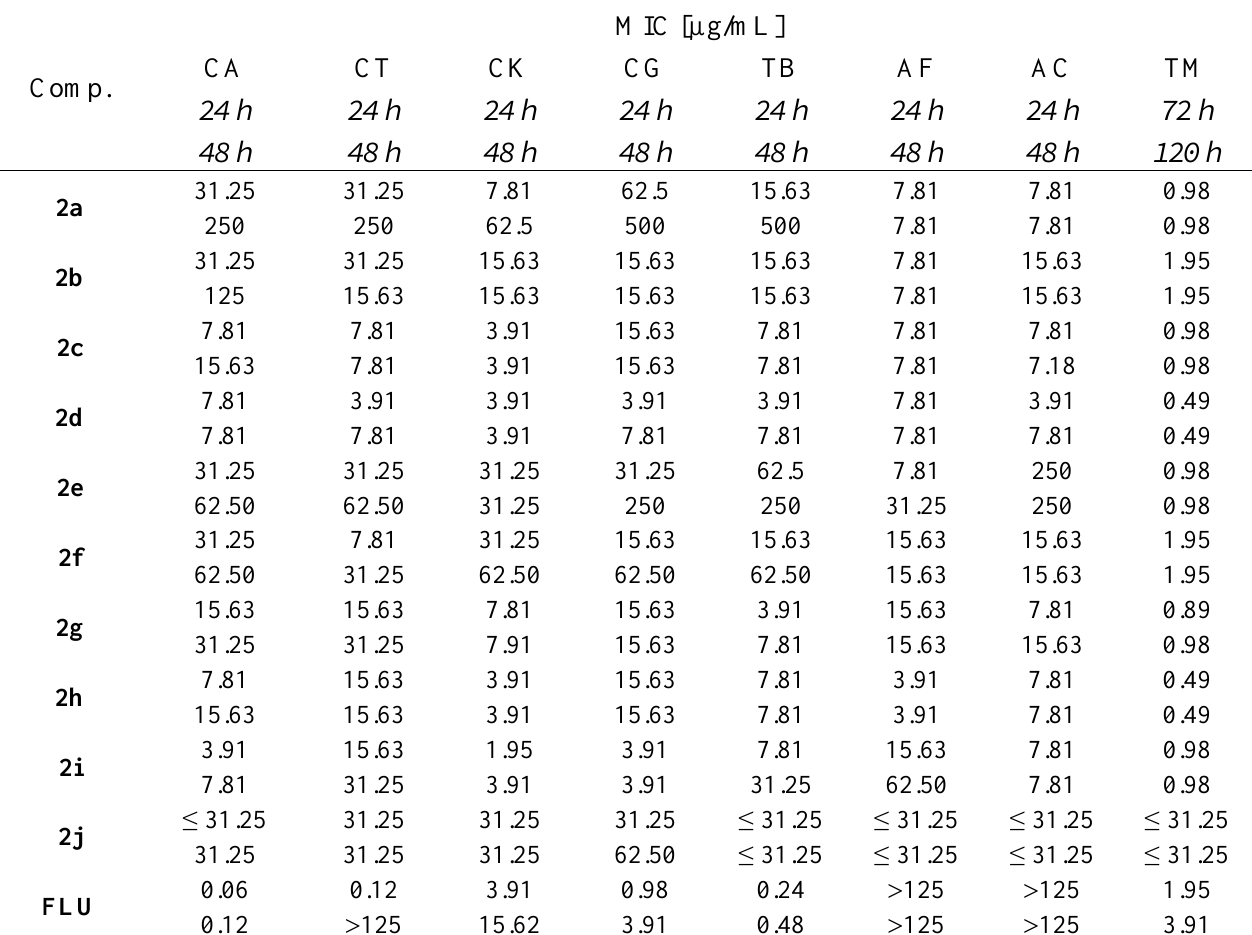
Table 3. In vitro antifungal activity of the compounds in comparison with standard fluconazole